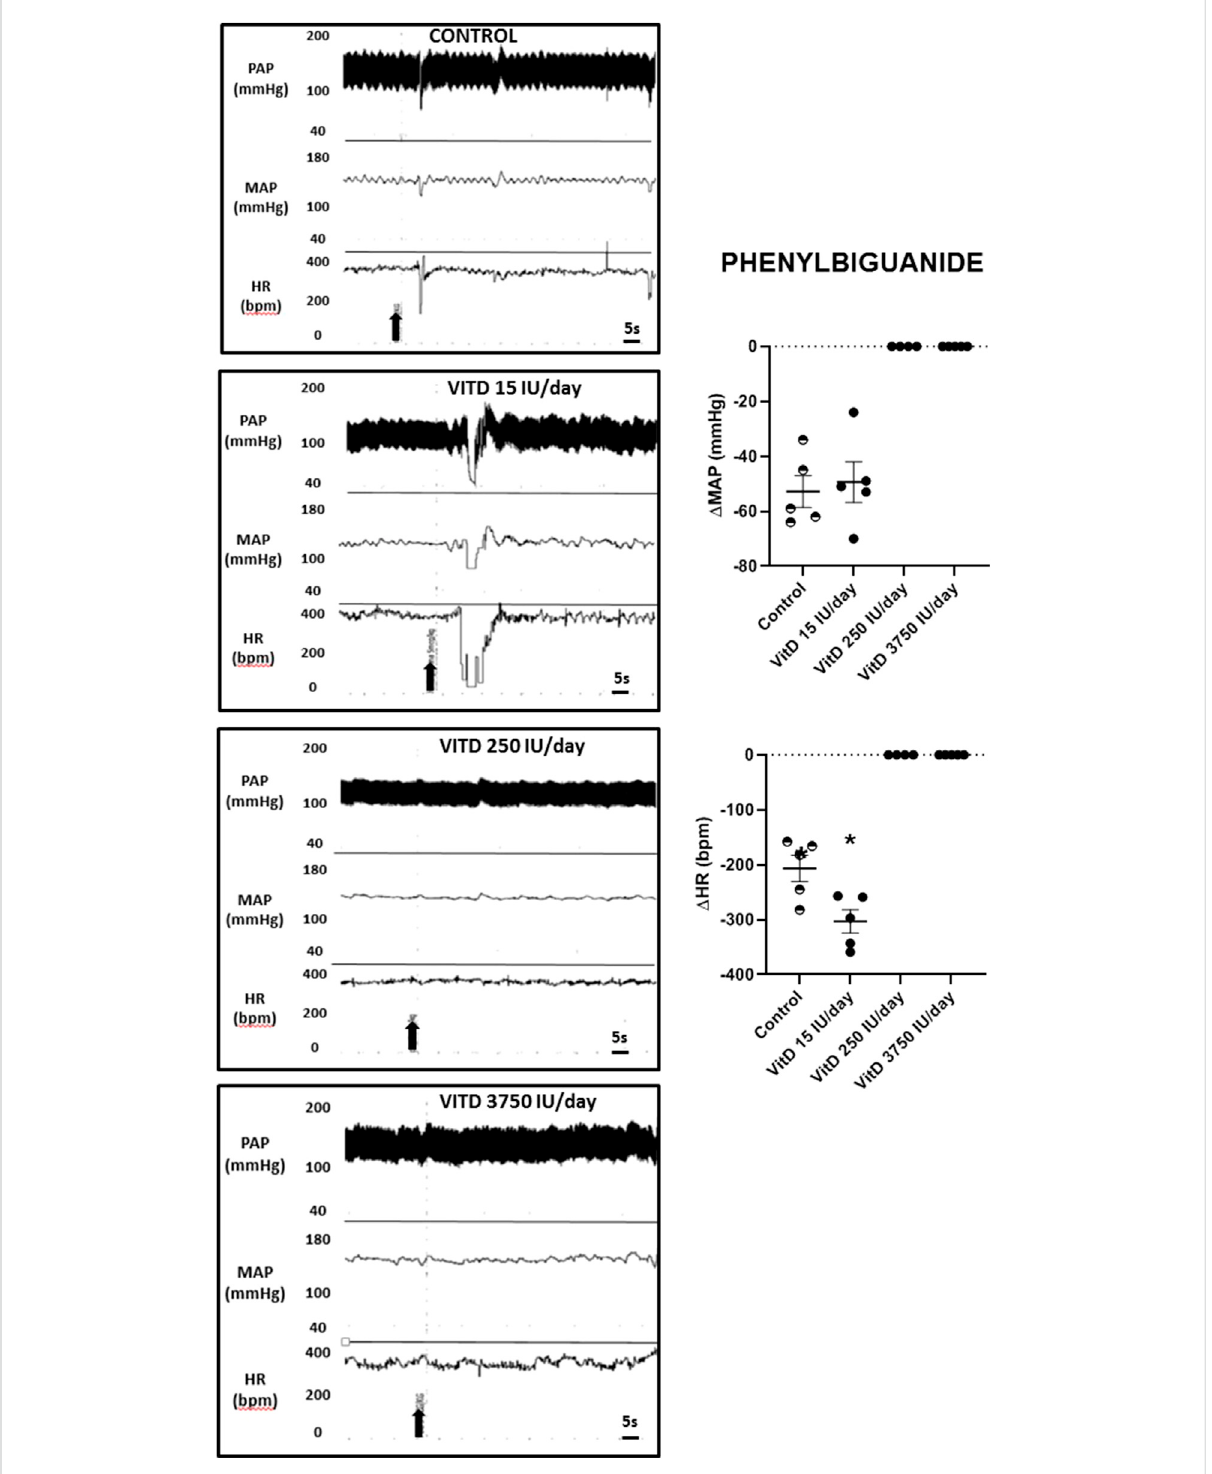
FIGURE 3 Left panels — Pulsatile arterial pressure (PAP), mean arterial pressure (MAP, mmHg), and heart rate (HR, bpm) tracings in Control, and Vitamin D 15,250and3,750 IU/day treated-rats for3 days inwhichphenybiguanide(5 μ g/kgofb.w.)wasadministratedintravenously.Rightpanels – Changein mean arterial pressure ( Δ MAP, mmHg) and heart rate ( Δ HR, bpm) elicited by phenylbiguanide (5 μ g/kg of b.w.) in Control rats and submitted to supplementation with different doses of Vitamin D (VitD 15, 250, 3,750 IU/day) for 3 days. ( n = 4 – 6/group). One-way